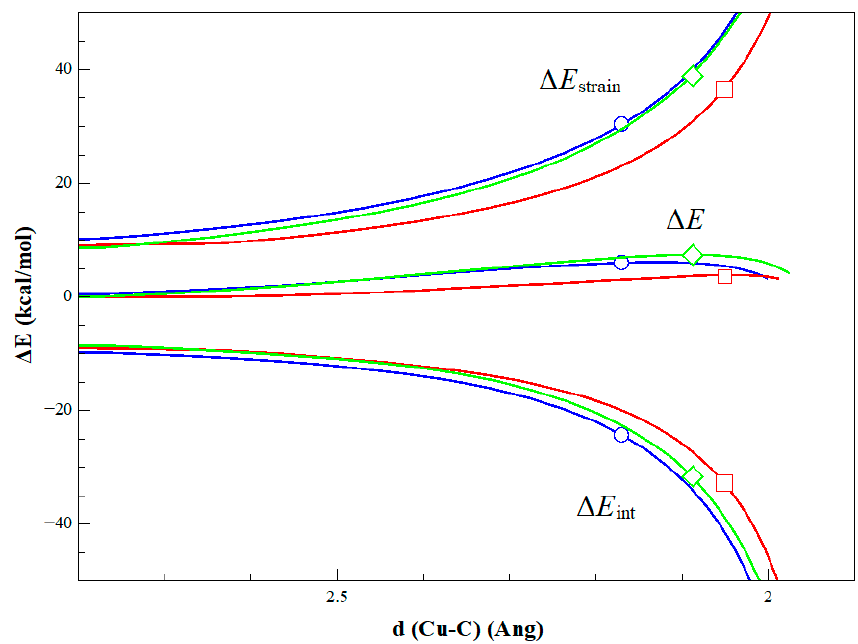
Figure 3. Activation Strain Model (ASM) diagram of the oxidative addition reaction of PhI ( 1 ) to [Cu(phen)XPh] where X = NH (blue curves), X = O (red curves), and X = S (green curves). The position of the corresponding TSs is indicated by a dot. All data were computed at the B3LYP + D3(BJ)/def2-TZVPP//B3LYP/def2-SVP level of theory.